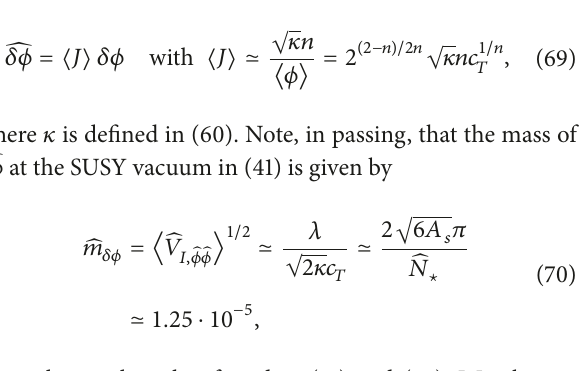
𝐾 = 𝐾 3𝑖 and (b) 2𝑖 . The values